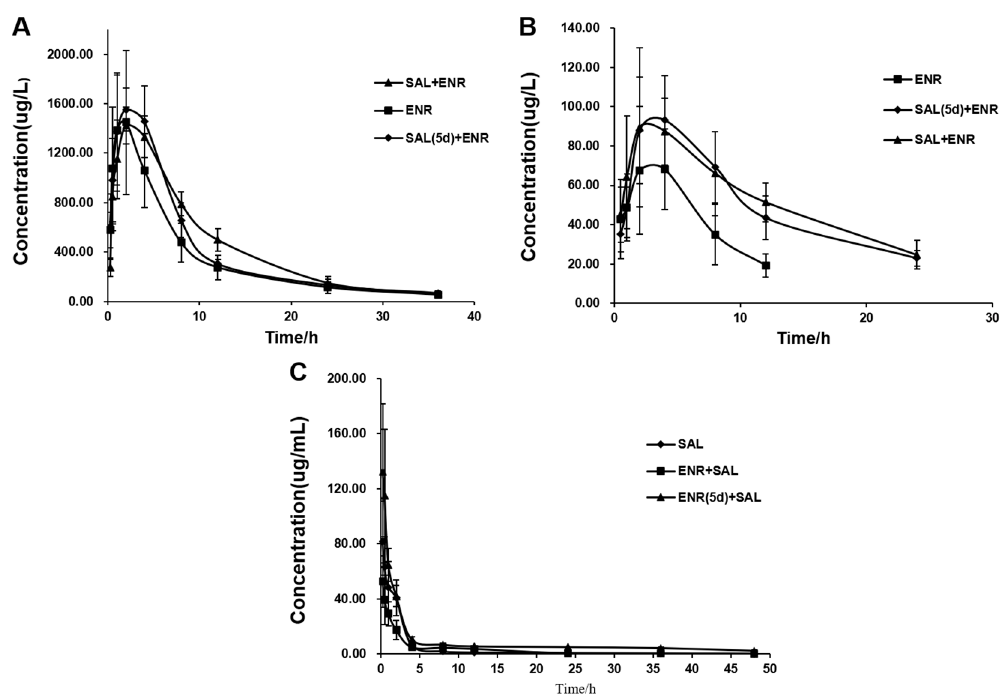
Figure 3. Drug concentration–time curves of ENR ( A ), CIP ( B ) and SAL ( C ) in broiler plasma after single or combined administration ( n = 6).